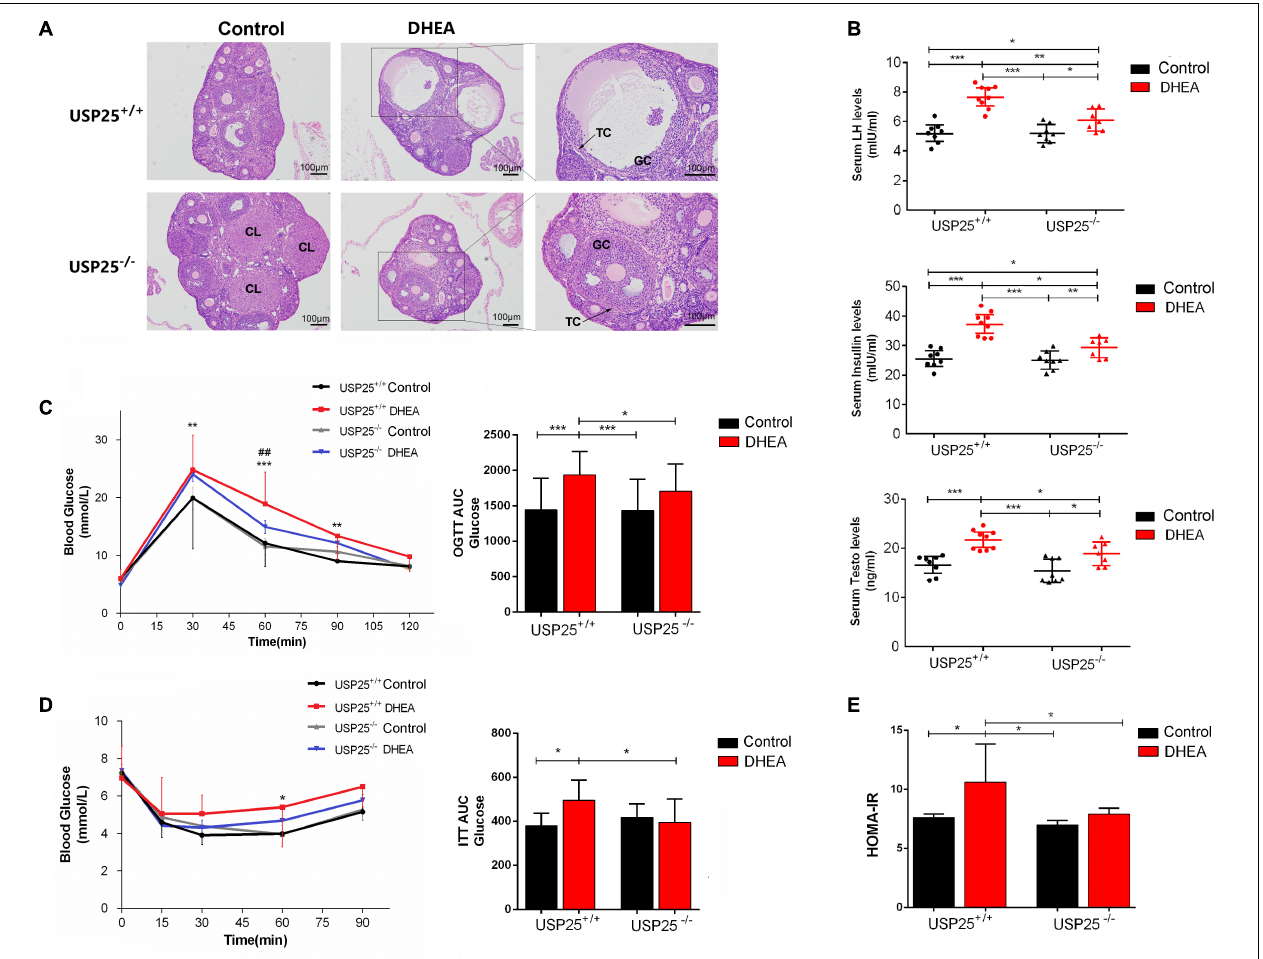
FIGURE 2 | The symptoms of PCOS were relieved in the USP25 − / − mice. (A) Representative images of H&E-stained mouse ovaries for the indicated groups. Scale bar = 100 µ m. TC, theca cells; GCs, granulosa cells; CL, corpus luteum. (B) The serum levels of LH, testosterone and insulin in mice exposed to the four treatments for 20 days ( n = 8 per group). * P < 0.05, ** P < 0.01, *** P < 0.001. (C) Glucose tolerance tests (GTTs) and the AUCs were assessed for the four groups. * P < 0.05 vs. USP25 + / + ; ## P < 0.01 vs. DHEA. (D) Insulin tolerance test (ITT) and AUCs for mice in the four groups. * P < 0.05 vs. USP25 + / + . (E) Homeostasis model assessment-insulin resistance (HOMA-IR) was analyzed based on fasting blood glucose and insulin levels. Data are expressed as the mean ± SD. The P -values were calculated by an unpaired two-tailed Student’s t -test. * P < 0.05, ** P < 0.01, *** P < 0.001. Four treatment groups of mice were used: USP25 + / +